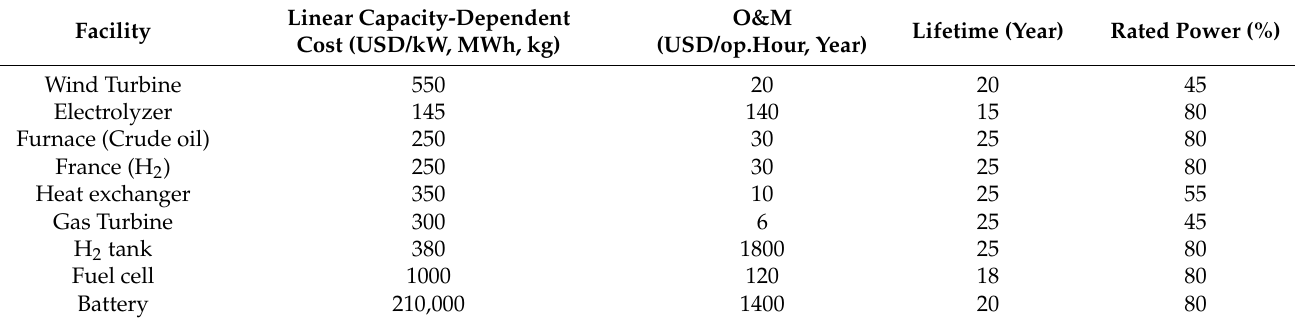
Table 9. Parameter of some equipment.